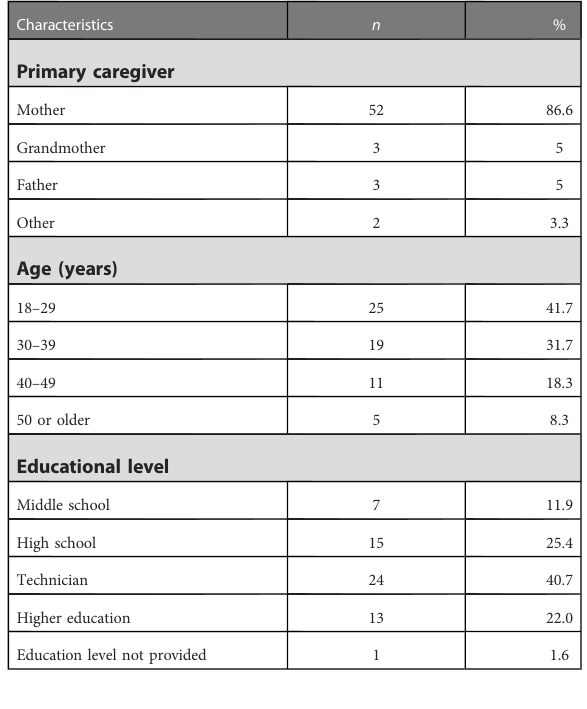
Table 2 identi fi es the characteristics of the caregivers, where